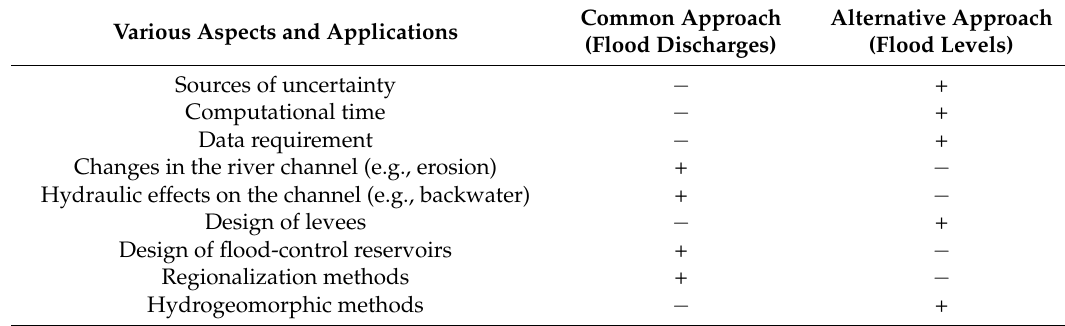
Table 1. Summary of pros (+) and cons ( − ) of the two